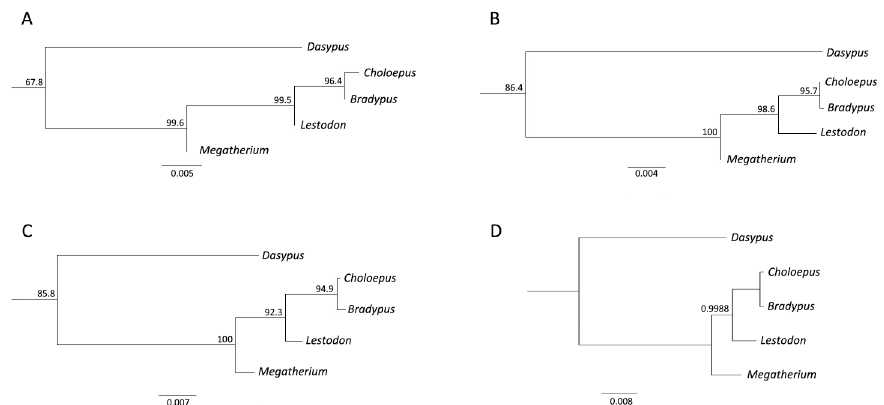
Fig 3. Phylogenetic analyses of COL1A2 sequences of eutherian mammals including the extinct South American native ungulates and two extinct ground sloths Lestodon and Megatherium in comparison to extant sloths Bradypus and Choloepus showing (A) Maximum Likelihood analysis of consensus peptide matches observed in the PMF, (B) Maximum Likelihood of peptide matches observed in the PMF from either specimen, (C) Maximum Likelihood of the alpha 2 (I) sequences only, using the Ensembl Choloepus sequence and (D) Bayes analysis of consensus peptide matches observed in the